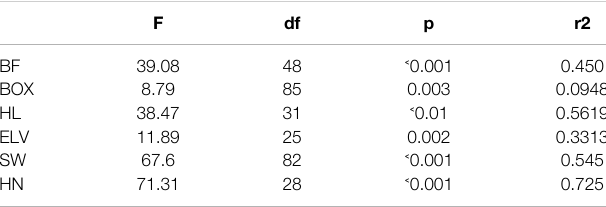
TABLE 5 | MANOVA results between SDI and volume (cm 3 ) of tools per